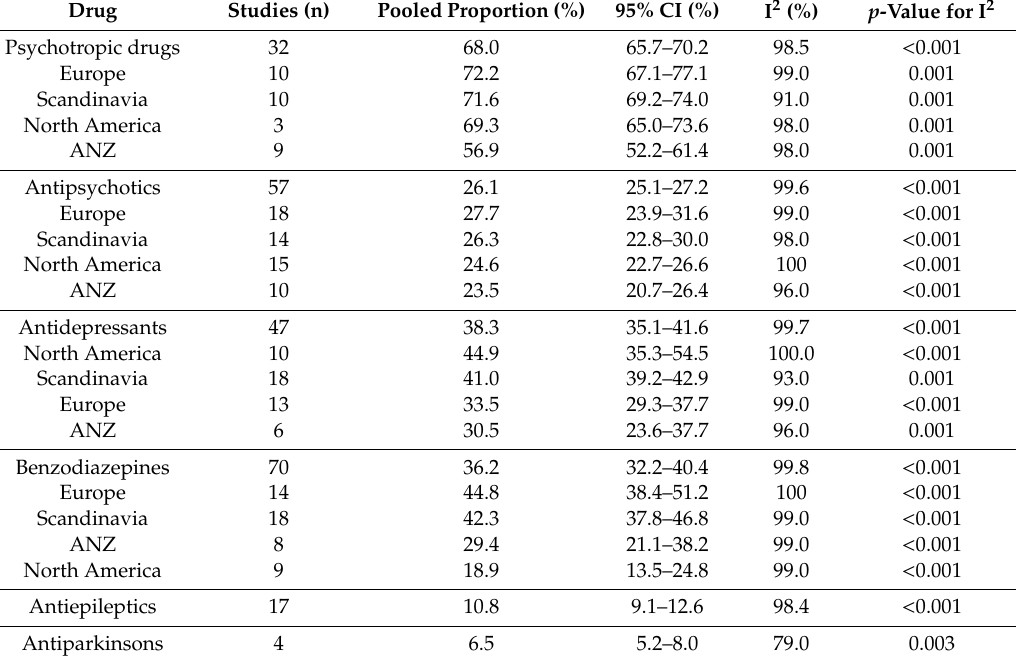
Table 4. CNS medicine use according to therapeutic classification and geographic